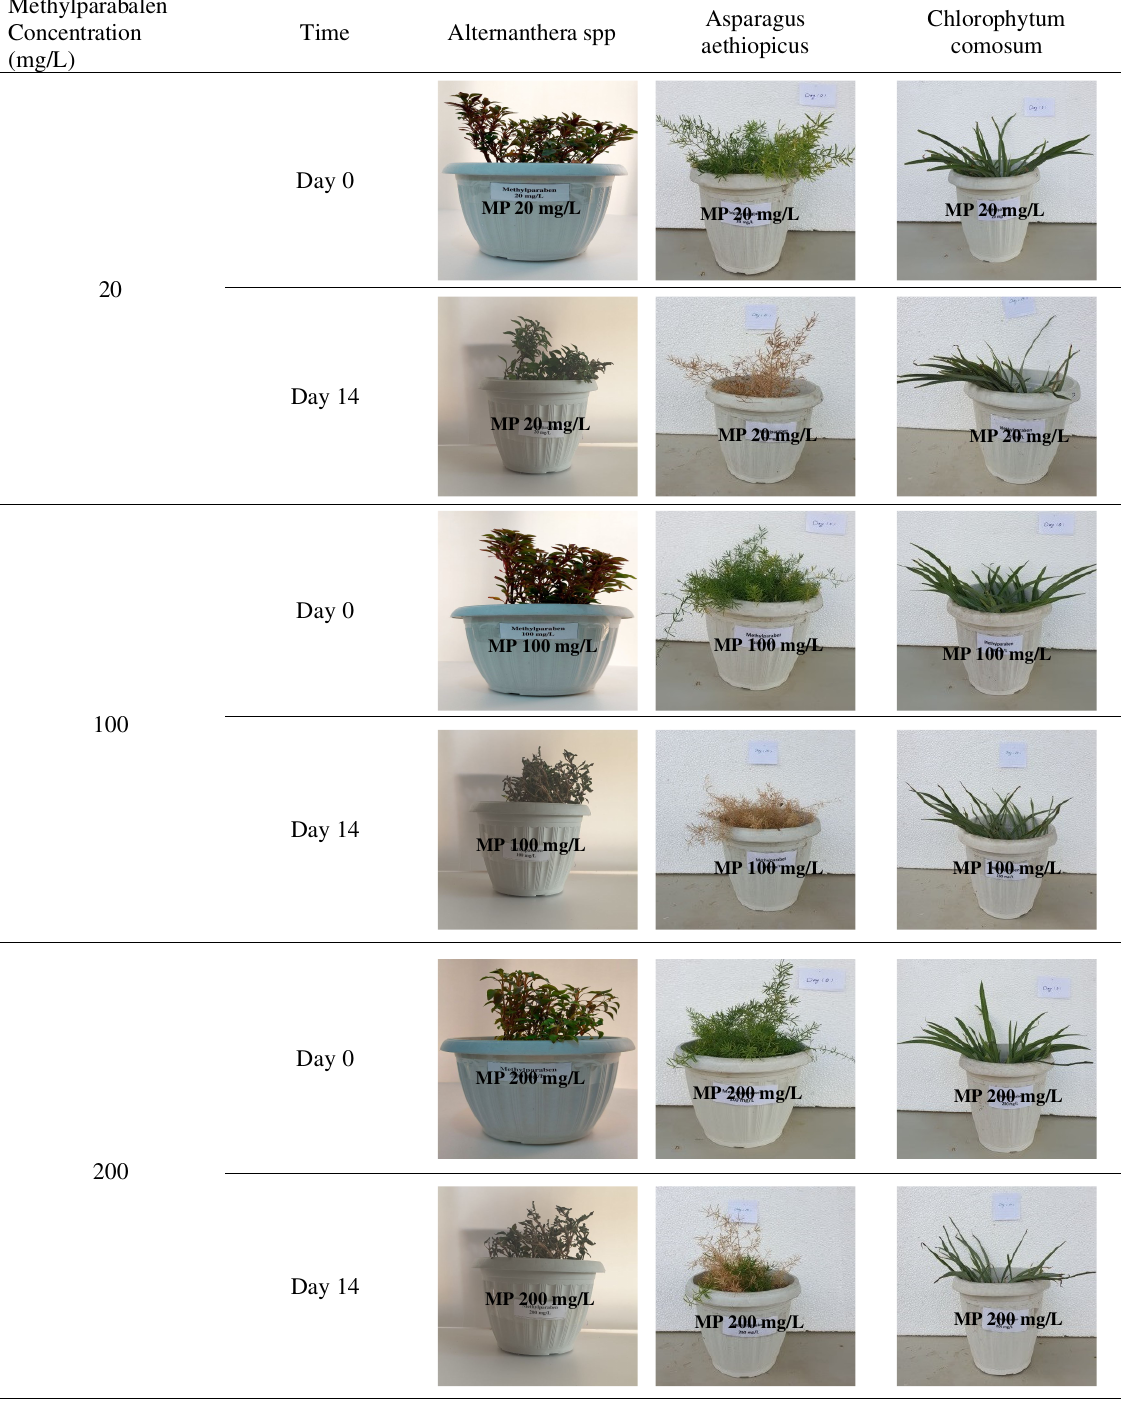
Table 4, The physical appearance of selected plants in methylparaben-exposed systems Methylparabalen